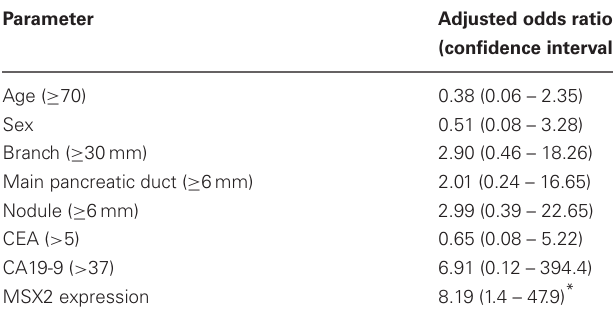
Table 4 | Predictive factors for malignant IPMN by multivariate analysis (Satoh et al.,